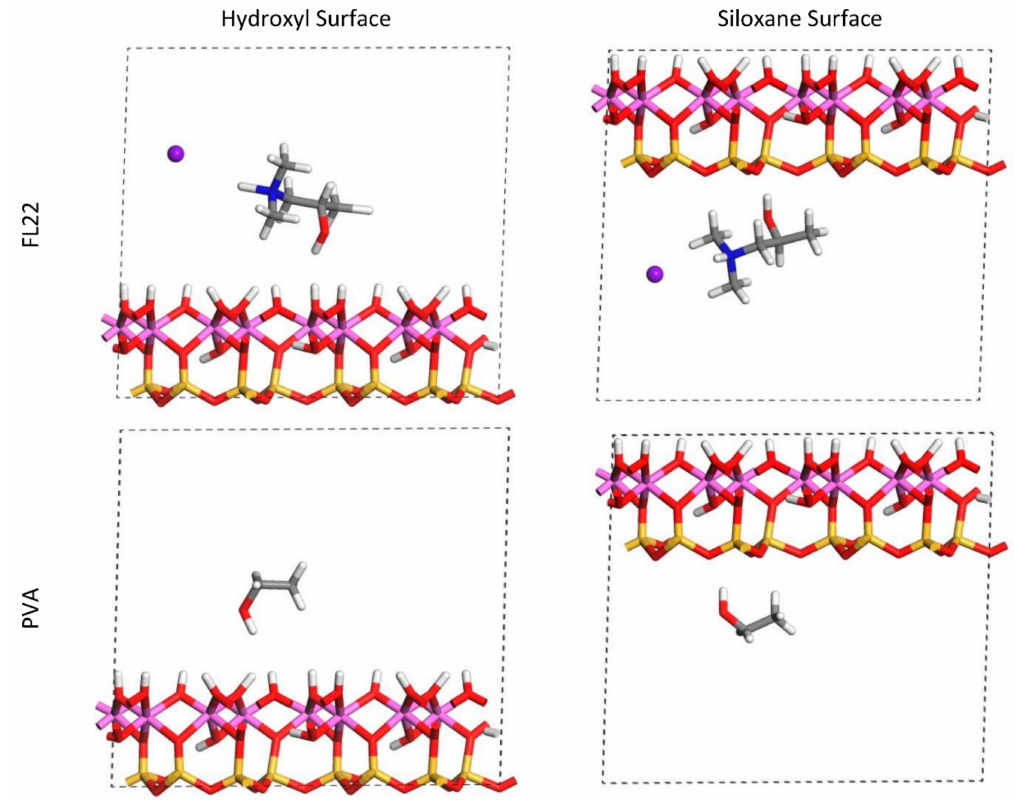
Figure 2. Orientation 2—Initial configurations of the monomer/surface models where the OH-group of the monomer points towards the